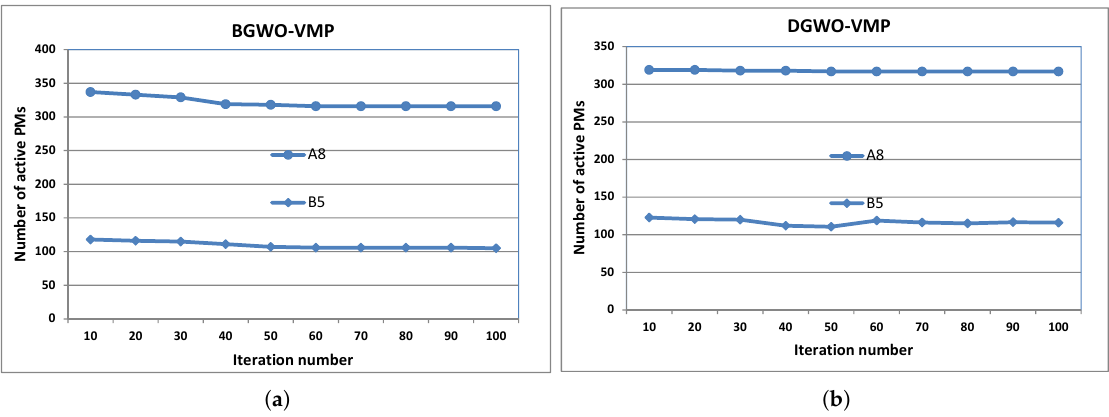
Figure 10. Influence of the number of iterations on BGWO-VMP ( a ) and DGWO-VMP ( b ) for both homogeneous and heterogeneous